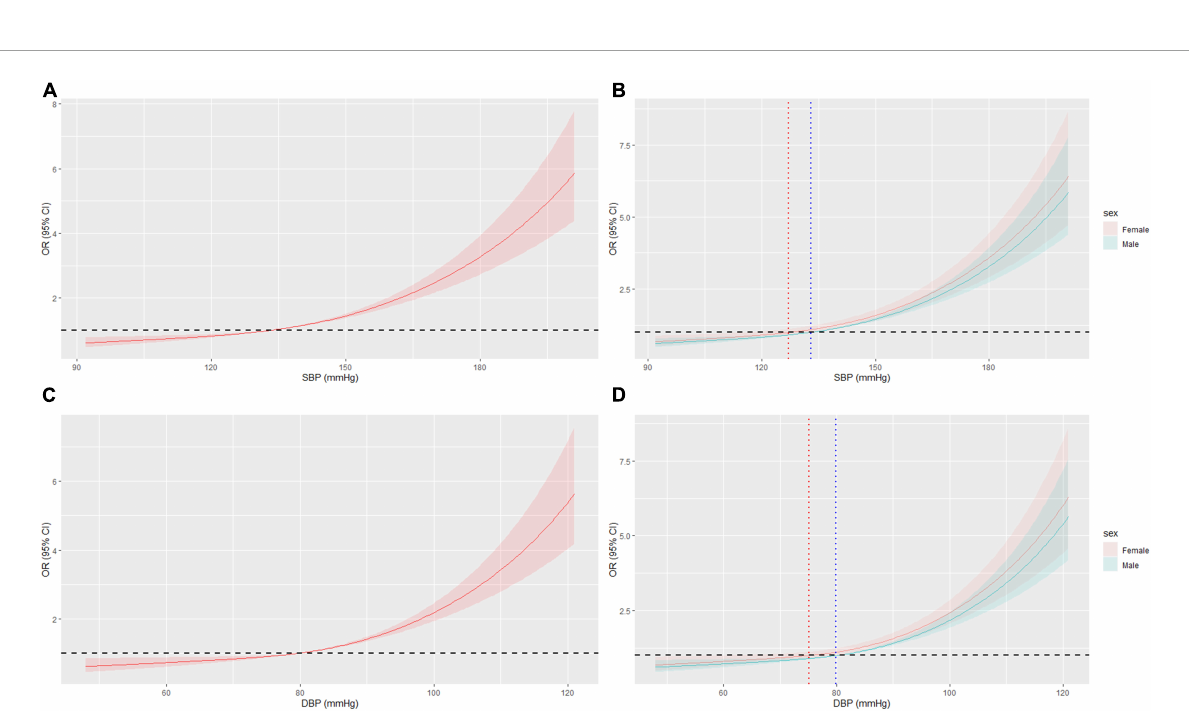
FIGURE3 Restricted cubic spline (RCS) of BP and AF in all patients after PSM. (A) RCS of SBP and AF. (B) RCS of SBP and AF in different sex, OR = 1 when SBP = 127.1 mmHg or 133.1 mmHg in female or male, respectively. (C) RCS of DBP and AF. (D) RCS of DBP and AF in different sex, OR = 1 when DBP = 75.1 mmHg or 79.9 mmHg in female or male, respectively. BP, blood pressure; AF, atrial fibrillation; OR, odd ratio; PSM, propensity score